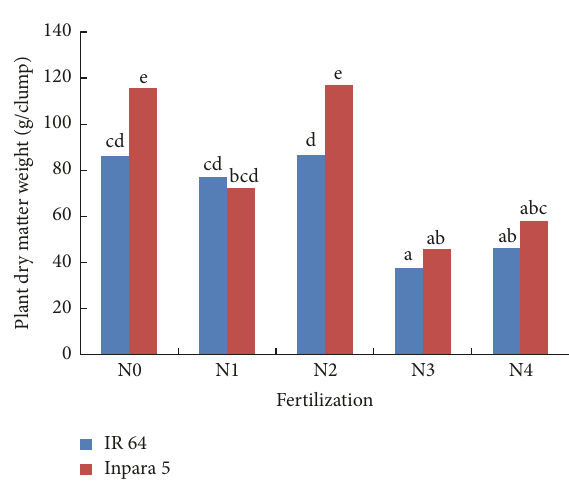
Figure 1: Plant dry matter weight at the end of research for two